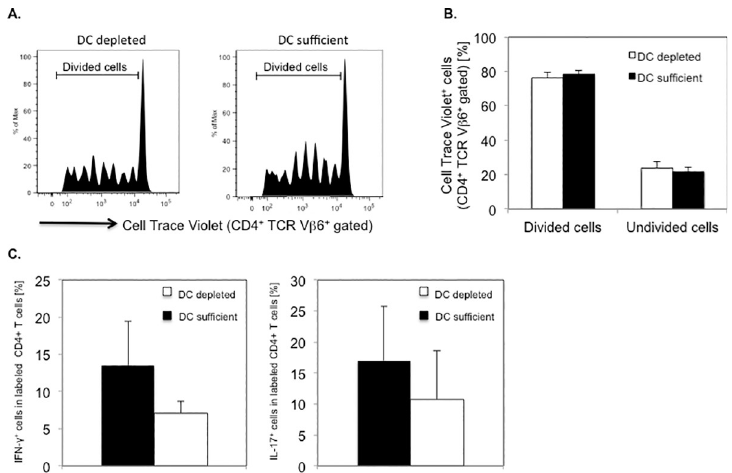
Fig 7. Efficient PLP-specific proliferation and cytokine responses by PLP TCR transgenic CD4 + T cells in DT treated CD11c-DTR SJL mice. DT treated CD11c-DTR SJL mice (n = 5) or DC sufficient control mice (n = 4) received CellTrace Violet labeled CD4 + T cells from na ï ve PLP TCR transgenic SJL mice. The mice were subsequently injected (s.c.) with PLP139-151 in CFA. Four days later, draining lymph node cells from one mouse of each group, were analyzed for cell divisions in PLP TCR transgenic (CD4 + TCR V β 6 + gated) T cells by flow cytometry. (A) Representative cell divisions in CD4 + TCR V β 6 + gated cells and (B) Mean frequencies ± SEM (%) of undivided (0 cell division) and divided ( > 1 cell division) CD4 + TCR V β 6 + gated cells from recipient mice of four independent experiments are shown. (C) Draining lymph node cells from DT treated CD11c-DTR SJL mice or control mice (n = 1 mouse/group) were stimulated overnight with PLP139-151 in vitro and assessed for intracellular cytokine production by flow cytometry. Data are shown as mean frequencies ± SEM (%) of CellTrace Violet + CD4 + T cells expressing IFN- γ or IL-17 of three independent experiments.